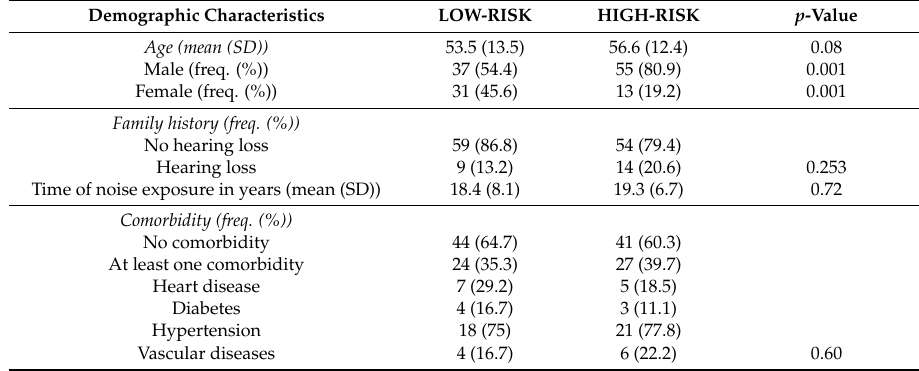
Table 1. Distribution of demographic characteristics between individuals with tinnitus in the LOW-RISK and HIGH-RISK groups. A significant prevalence of male gender was found in the HIGH-RISK group. No significant differences were found for age, time of noise exposure, family history of noise exposure and cardiovascular comorbidities between the two